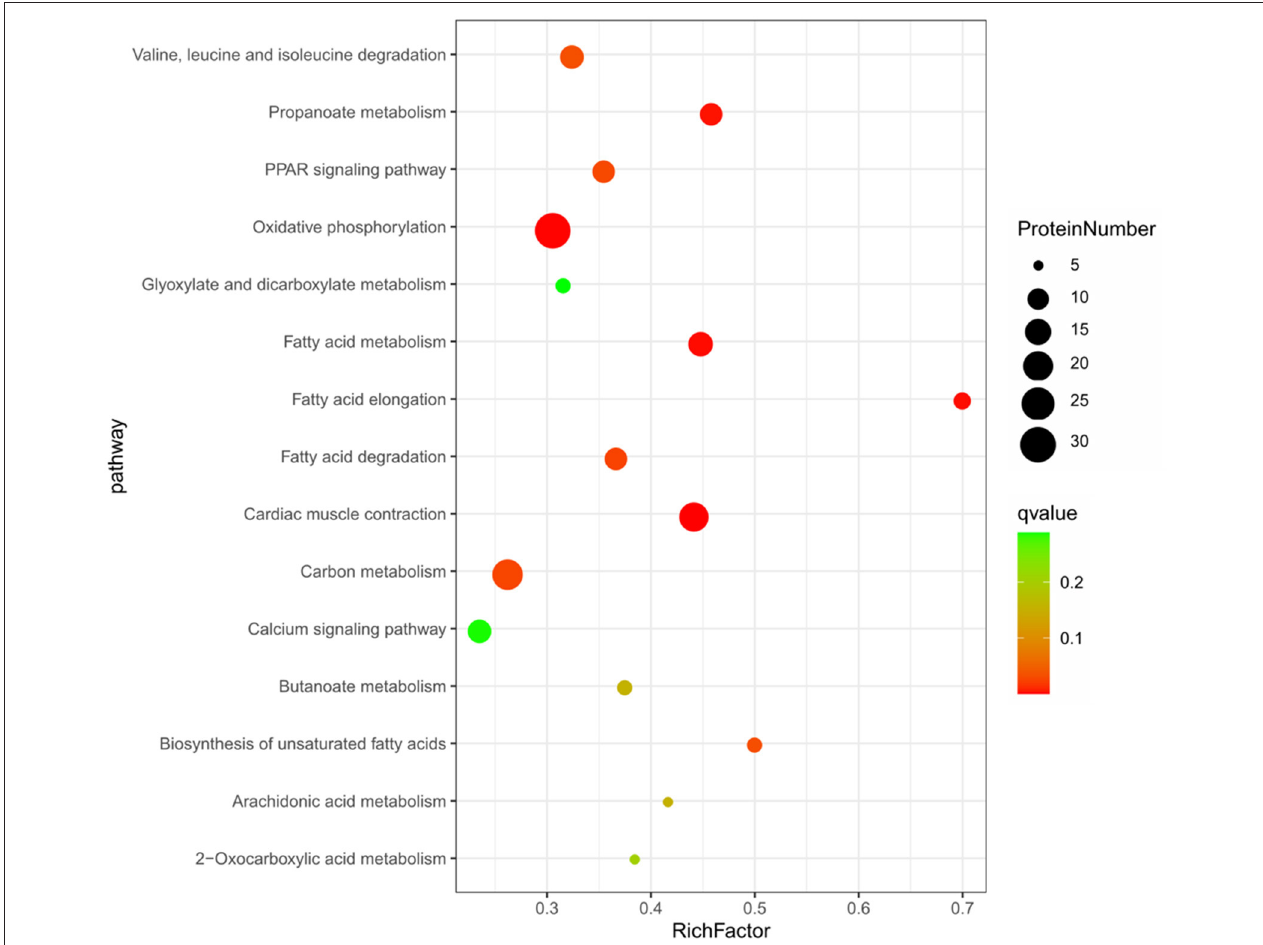
FIGURE 3 | The top 15 enriched KEGG pathway based on the 664 differentially expressed